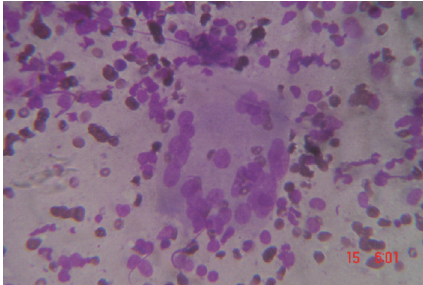
Figure 1: Numerous multinucleated histiocytic giant cells and scant epithelioid cells seen in thyroid tissue of woman presenting with Subacute thyroiditis (May-Grunwald-Giemsa stain; original magnification 450, reduced by